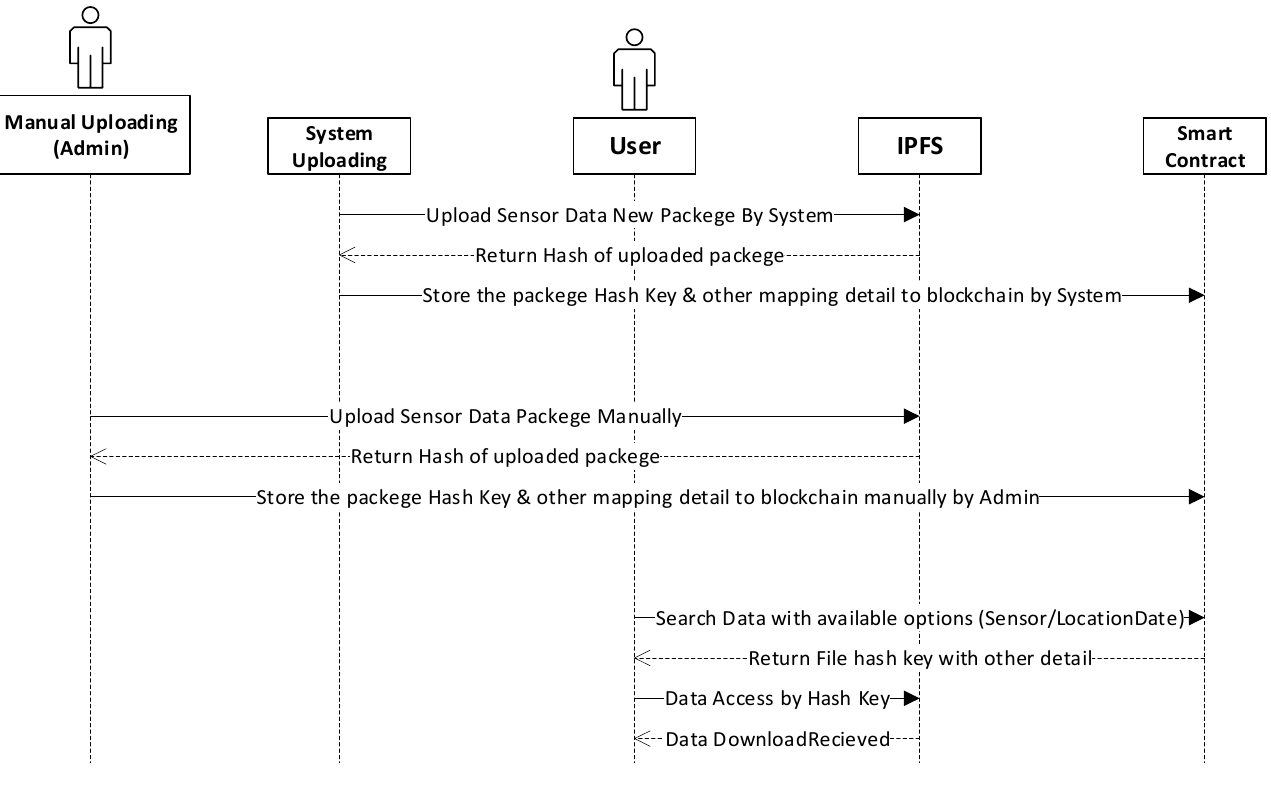
Figure 10. Data sharing